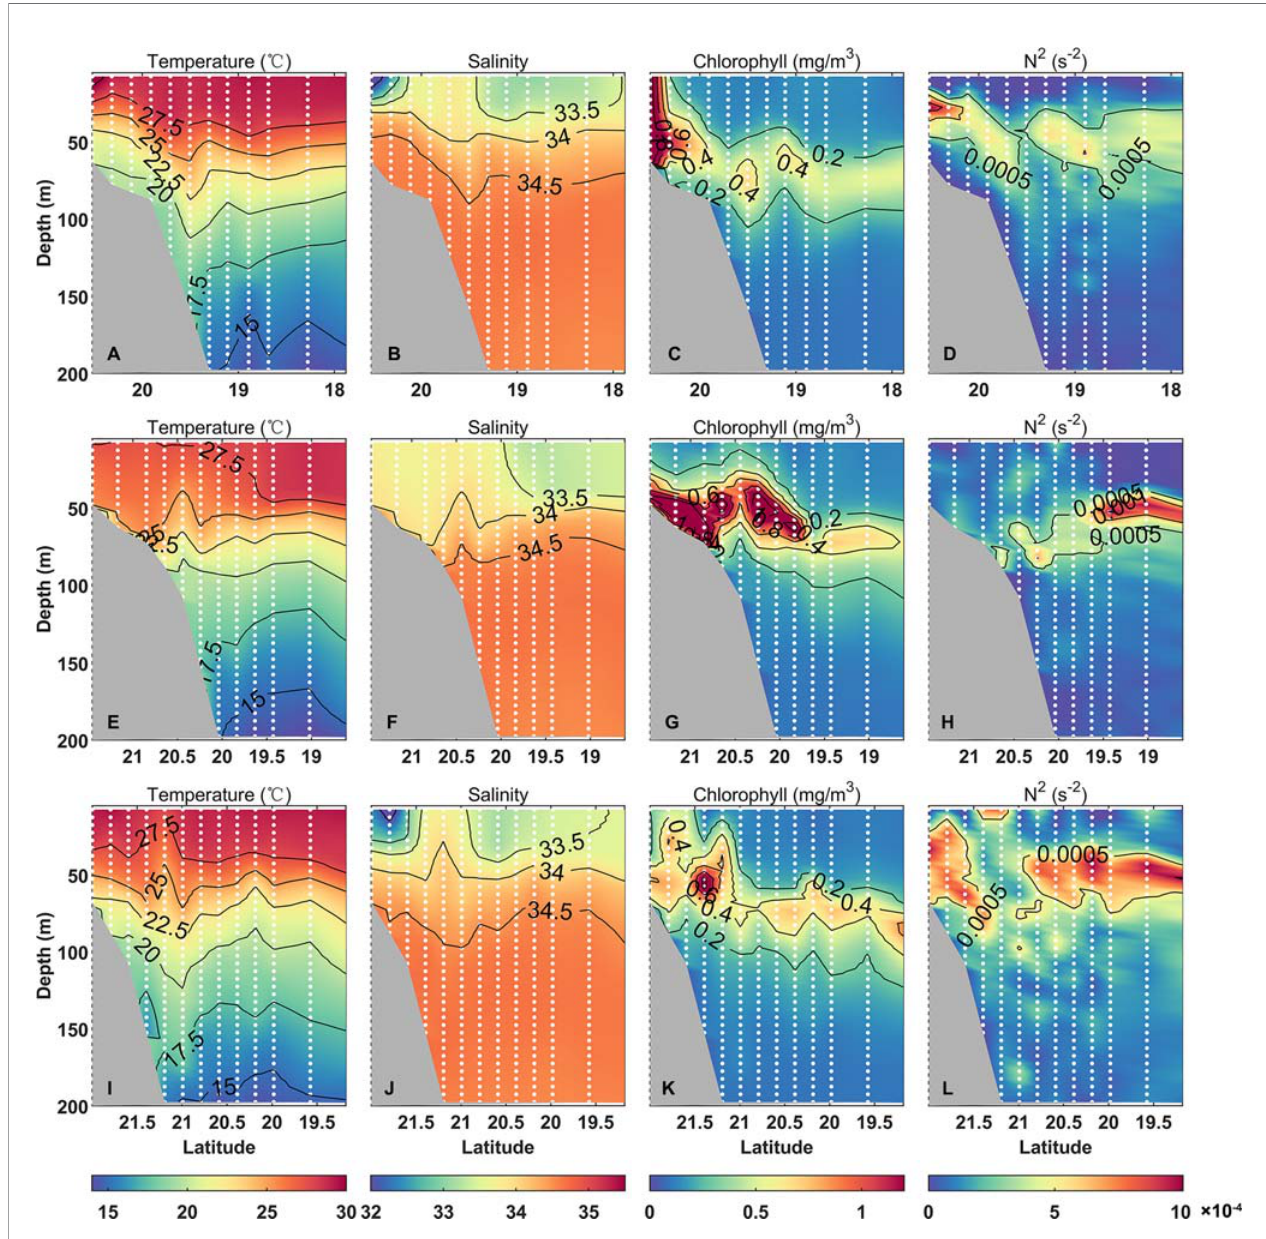
FIGURE 4 | Three transects [S1: (A – D) , S2: (E – H) , S3: (I – L) ] of temperature (°C, left panel), salinity (the second panel), chlorophyll concentration (mg/m 3 , the third panel), and Brunt-Väisälä frequency (s − 2 , right panel). The solid white dots are the positions of the